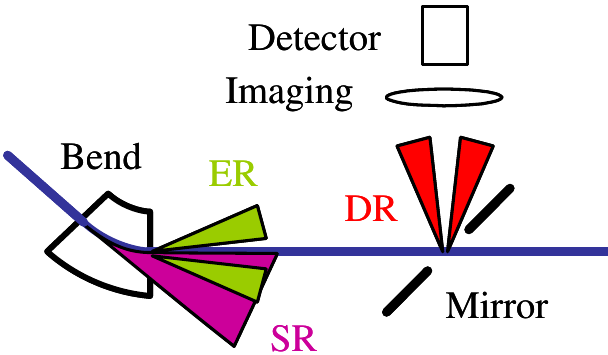
FIG. 23. (Color) Radiation source viewed by bunch length moni- tor BL11 . The pyroelectric detectors measure primarily coherent edge radiation of the final BC1 bend, reflected into the detector by an insertable mirror with a 0.6-inch diameter hole to pass the electron beam.